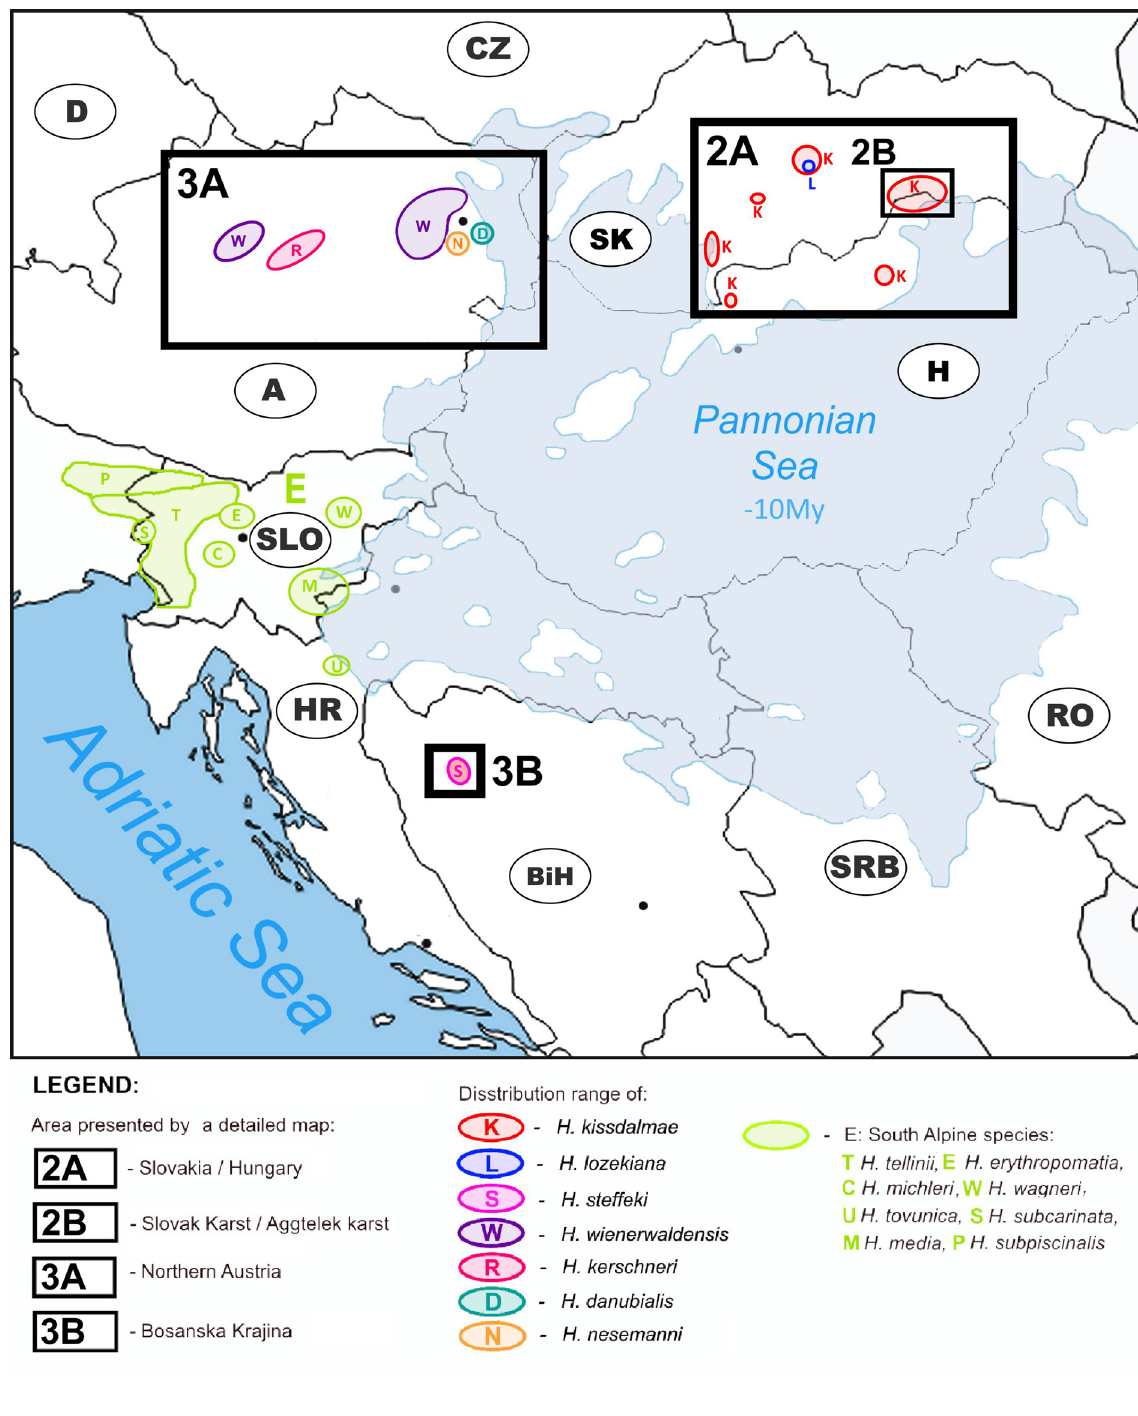
Fig. 1. Current distribution of Hauffenia Pollonera, 1898 in relation to the extension of the Pannonian Sea 10